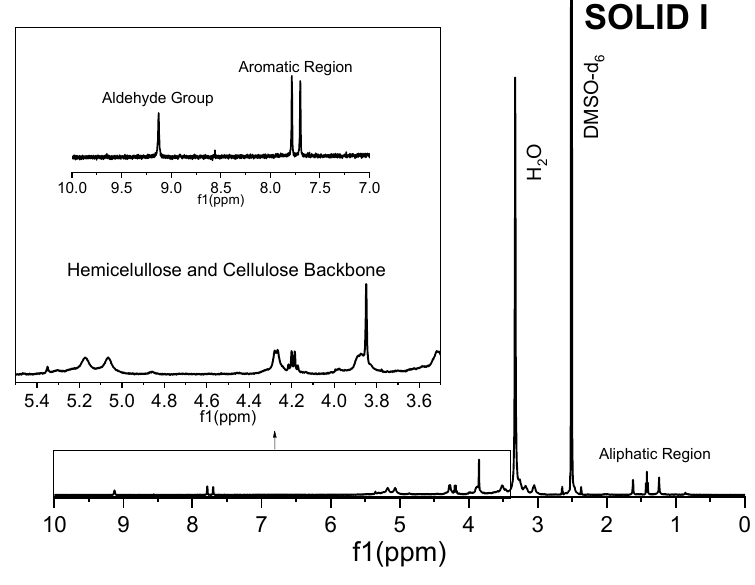
Figure 5. 1 H NMR spectrum of Solid I.